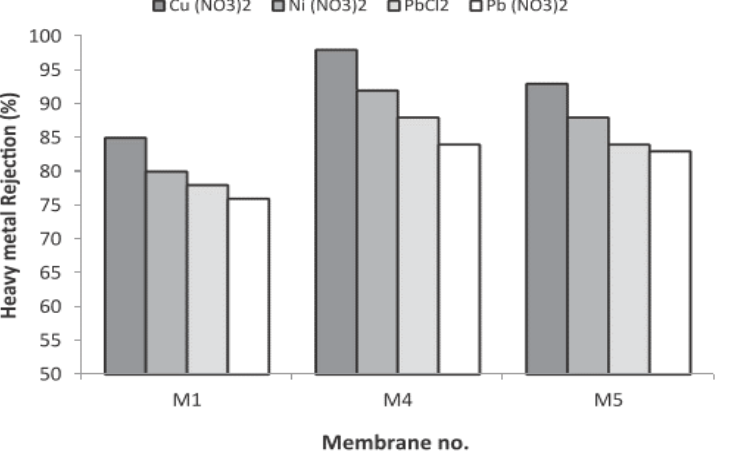
Figure 4. Heavy metal removal by using pristine membrane (M1) and MMMs (M4 and M5) Adapted with permission from ref. [95]. Copyright 2021 Elsevier.